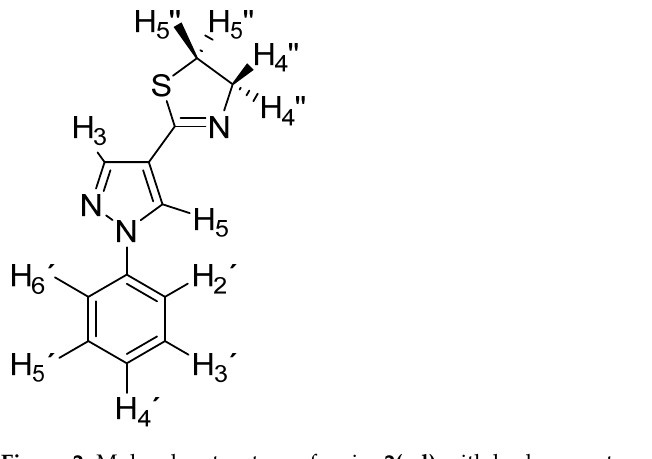
Figure 2. Molecular structure of series 2(a-l) with hydrogen atoms highlighted.